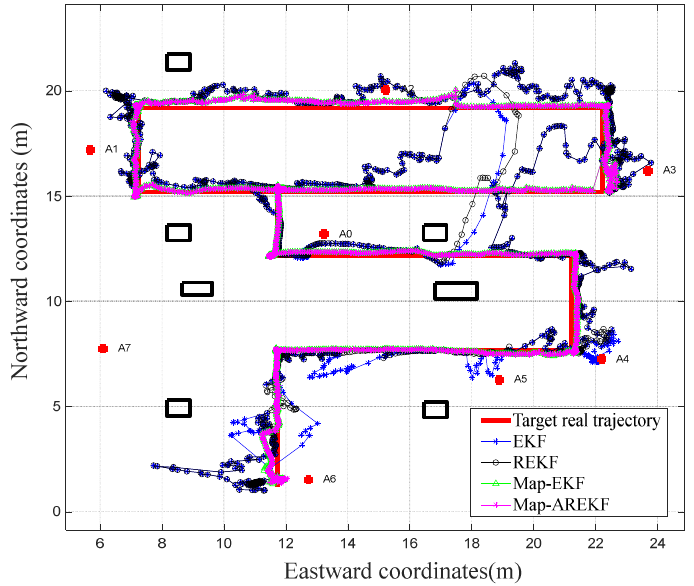
Figure 11. Comparison of the solution results of four localization algorithms for Experiment 1. Using RT to calculate the ranging errors of each anchor, the errors are shown in Figure 12. It can be seen that the ranging values are seriously deviated by the NLOS caused by the spatial structure. In particular, the anchor A6 has a ranging error of more than 10 m in part of the epochs in the d 6 -d 7 section which, combined with the spatial structure analysis, shows that the error is due to the influence of NLOS caused by Columns 5 and 6.